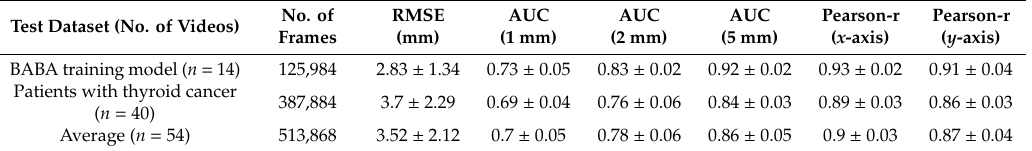
Table 3. Comparative performance of methods detecting the tips of surgical instruments. Evaluation methods included determinations of average root mean square error (RMSE; mm), average area under the curve (AUC; 1, 2 and 5 mm), and average Pearson correlation coe ffi cient ( x -axis and y -axis) between tip positions determined by the algorithm and ground